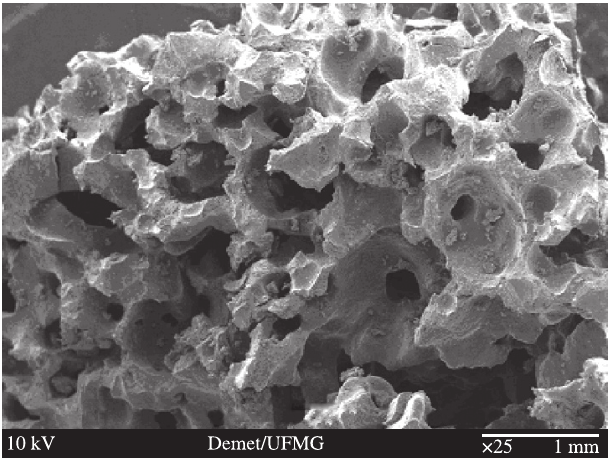
Figure 4. SEM image of the porous polyurethane nanocomposite.